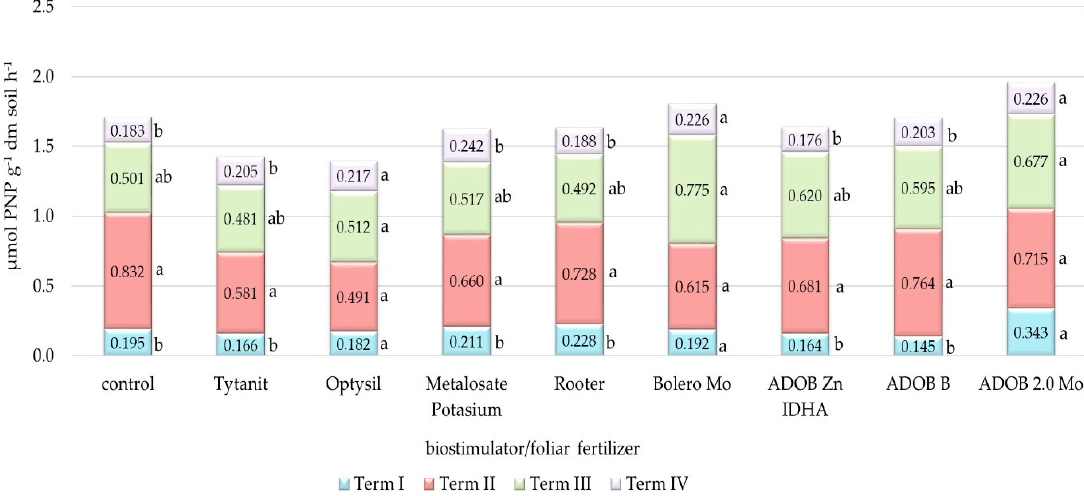
Figure 6. The influence of the bio-stimulants and fertilizers on the alkaline phosphatase level. Abbreviation: a, b—homogenous groups according to Duncan’s test at level p = 0.05; I term—at the plants’ emergence (BBCH 5–10), II term—at the plants’ full growth (BBCH 35–40), III term—at the